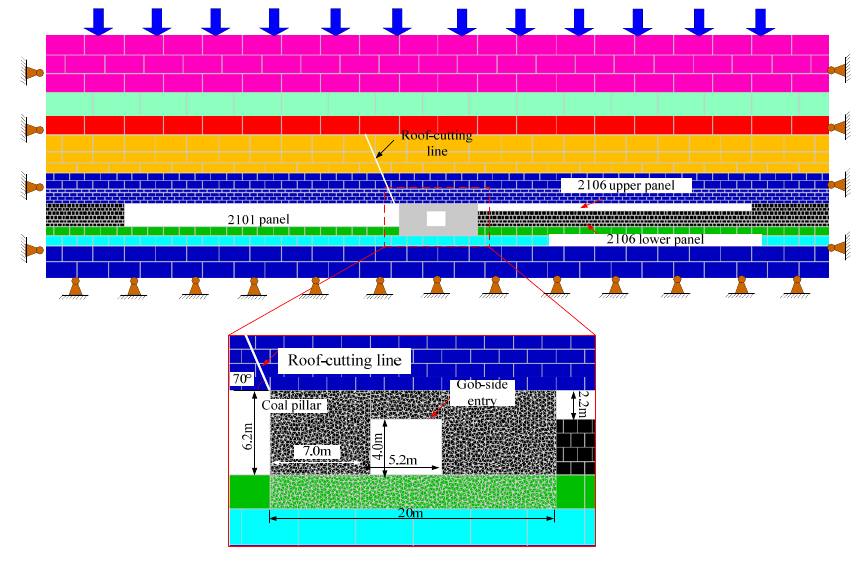
Figure 12. Numerical model.